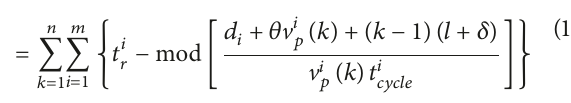
internal stability and scalability of homogeneous vehicular platoon